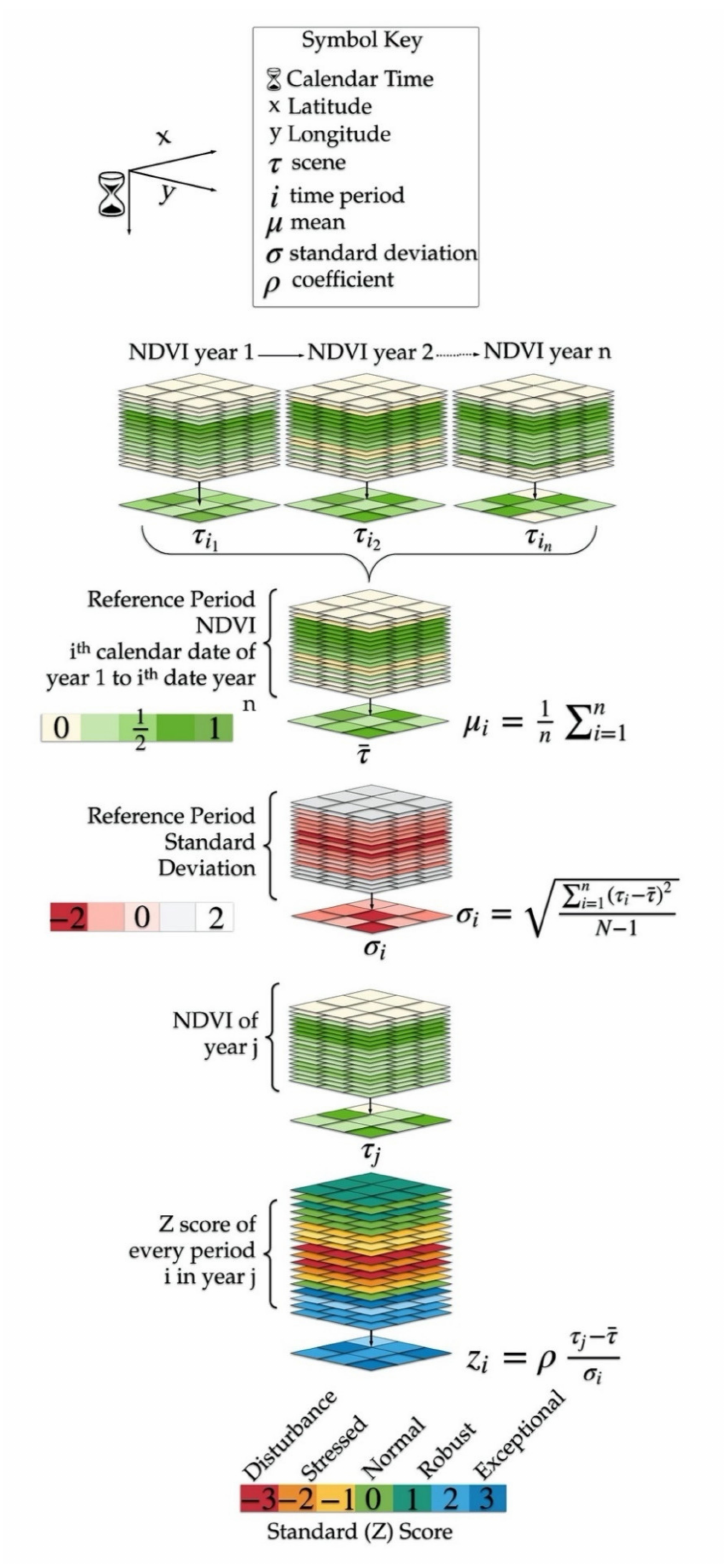
Figure 2. The Ecosystem Moisture Stress Index (EMSI) is derived from multi-year time series of NDVI, where the NDVI of every pixel (xy) for the date of interest ( j ) are differences from the mean ( µ ) of the reference period (T), divided by the standard deviation ( σ ) of the shared dates, resulting in a standard ( z )